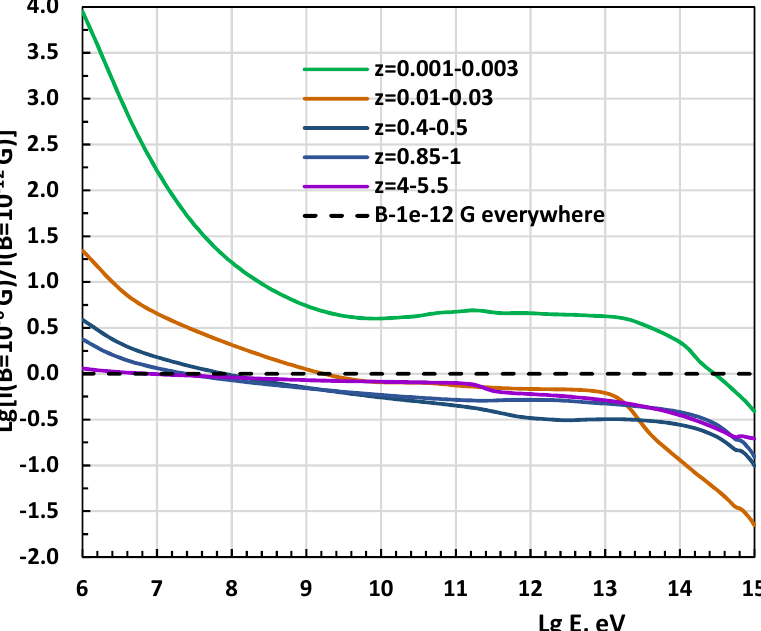
Figure 2. The ratio of cascade gamma-ray intensity with B = 10 − 6 G to that with B = 10 − 12 G for UHECR sources at various distances from Earth (see the